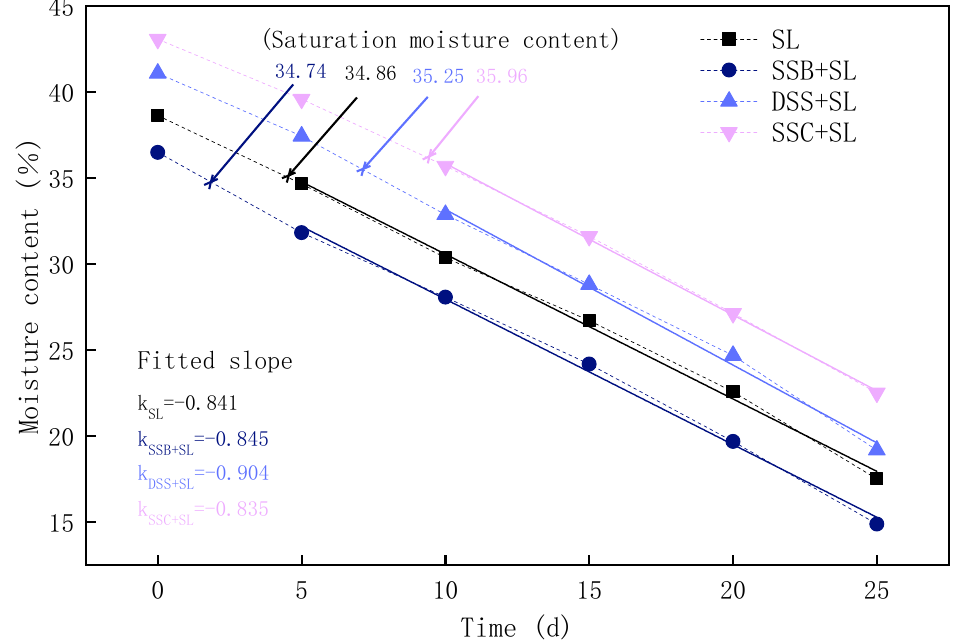
Figure 1. Changes in moisture content of four soil samples (SL, SSB + SL, DSS + SL, SSC + SL). As shown in Figure 2, compared with the control group, the porosity of the three groups of modified soil changed to some extent. The total porosity of the SSC-modified soil increased slightly and mostly increased by non-capillary pores. The total porosity of the DSS-modified soil and SSB-modified soil did not change much, but compared with that of control loam, the capillary porosity decreased while the non-capillary porosity increased. Under natural conditions, when the pores between soil particles (including capillary pores and non- capillary pores) are filled with water, the moisture content is at what is called the saturated moisture content, which could be increased by adding SSC and DSS. The application of SSB reduced the saturated moisture content of the soil (Figure 1), Moreover,